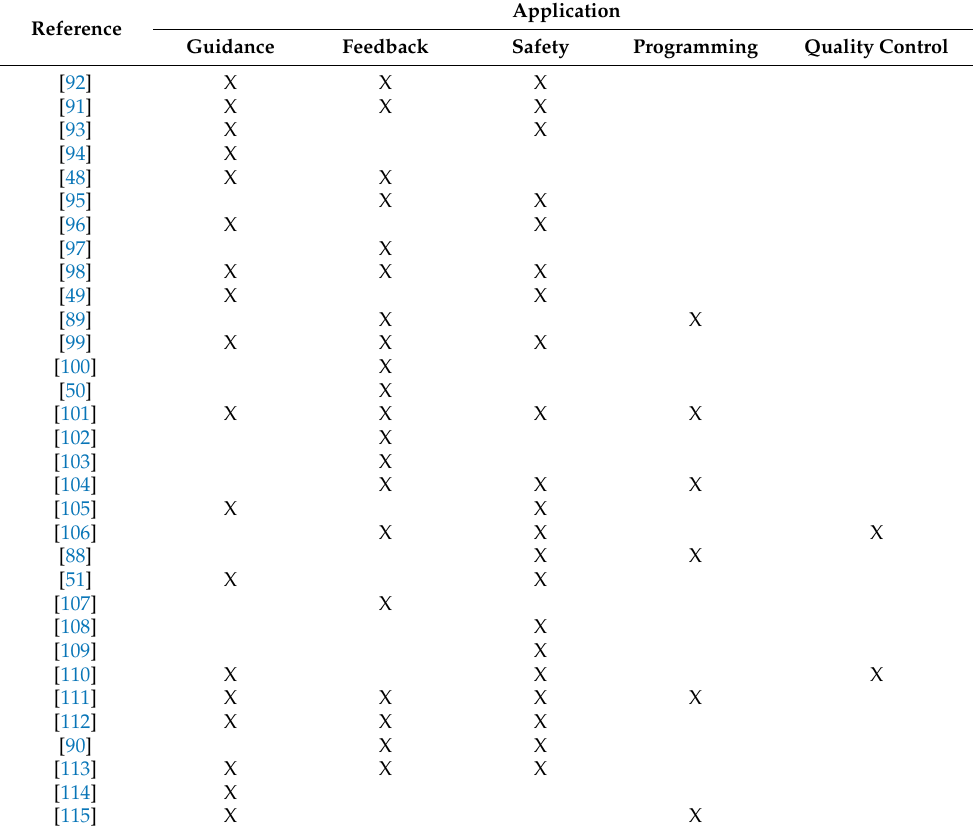
Table 13. Papers’